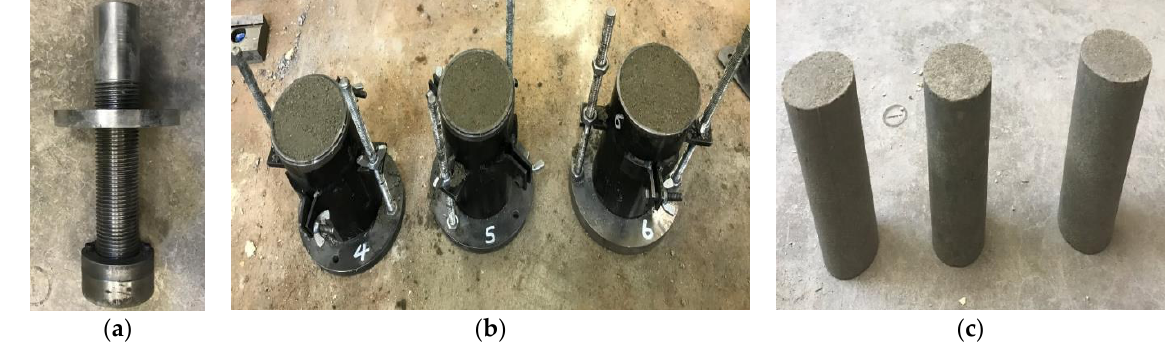
Figure 4. ( a ) Compactor, ( b ) samples in the moulds, ( c ) unmoulded samples. The stress – strain diagrams obtained from the UCS tests are presented in Figure 5.